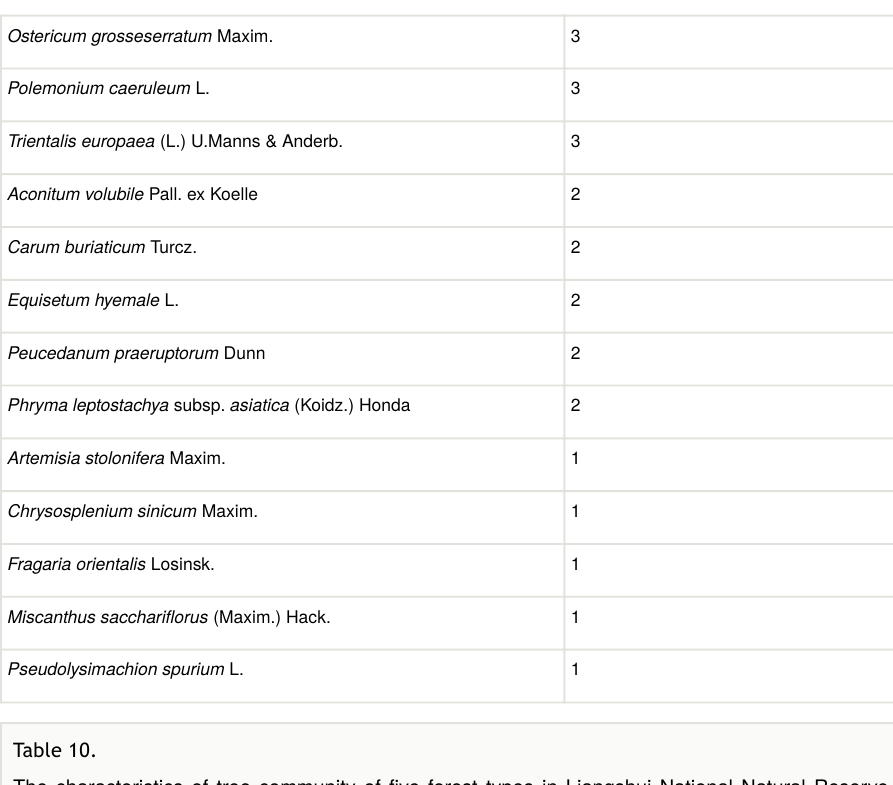
The characteristics of tree community of fi ve forest types in Liangshui National Natural Reserve, where: UPF = Ulmus davidiana var. japonica — Pinus koraiensis forest; BPF = Betula costata